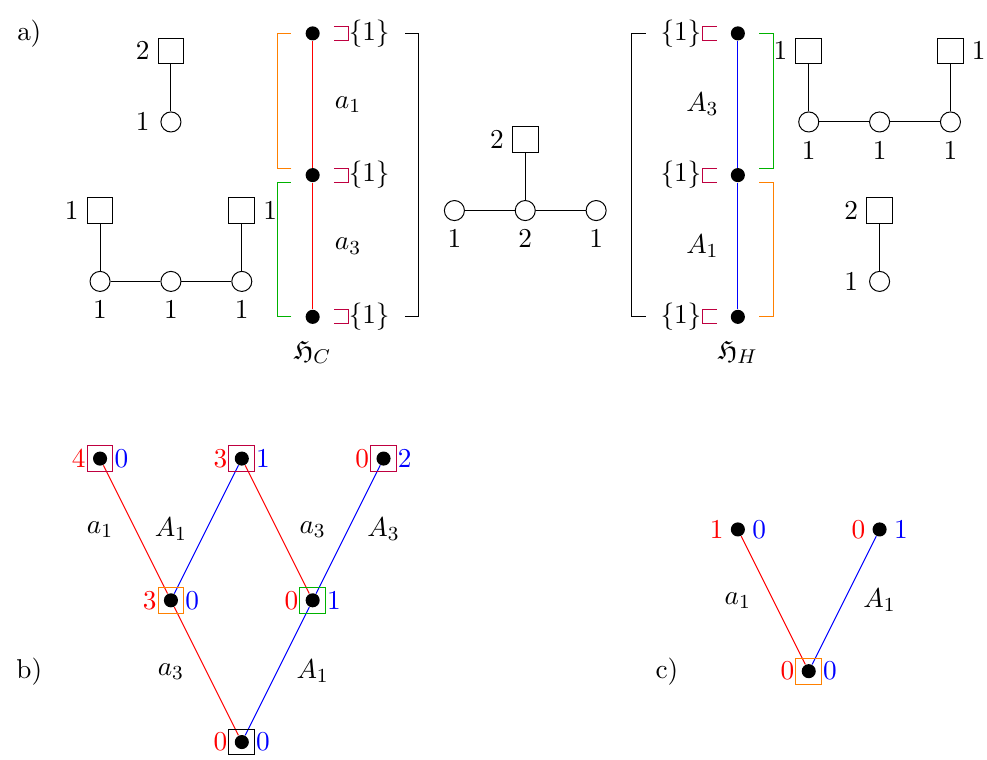
Figure 6 . a) (left) The Hasse diagram of the Coulomb branch, which in principle contains all of the information, encoded in the transverse slices. a) (right) The Hasse diagram of the Higgs branch, which in principle contains all of the information, encoded in the transverse slices. All the trivial transverse slices (purple) correspond to points in the highest leaves of the entire moduli space. All the elementary slices (green, orange) correspond to the transverse spaces of minimal degenerations of the highest leaves in the Hasse diagram of the full moduli space. b) The Hasse diagram of the moduli space of the theory (2.3). The coloured boxes around the nodes are in bijection with the transverse slices in the Higgs branch as well as the Coulomb branch. All effective theories for this example can be read off the brane diagrams in figure 4. c) As an example: the transverse space to the orange leaf inside the entire moduli space, the moduli space of U(1) with 2